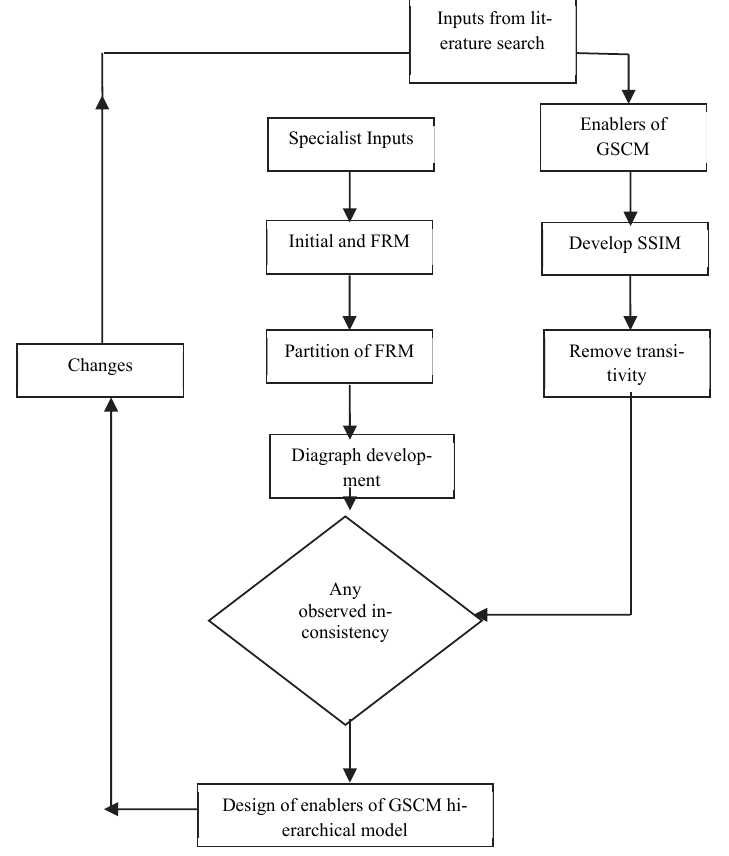
Fig. 1. ISM Model for Enablers of